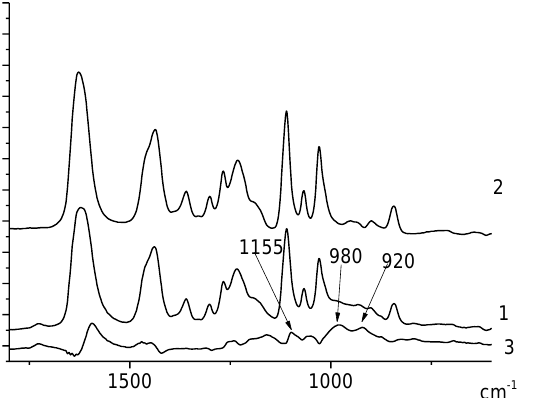
Figure 3. FTIR spectra of poly(4-acryloylmorpholine) (1), 4-AM-VPA copolymer (Experiment 5, Table 1) (2), the difference spectrum (3).